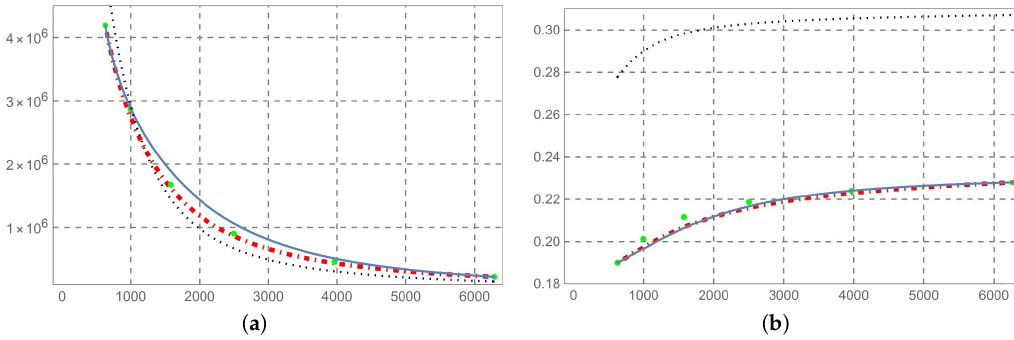
Figure 2. ( a ) Permittivity and ( b ) conductivity at frequencies 100 Hz @ 1 KHz. Line dot-dashed fractional model α = 0.983, line continue ordinary model, line dotted extensive Cole–Cole’s model, points experimental data.